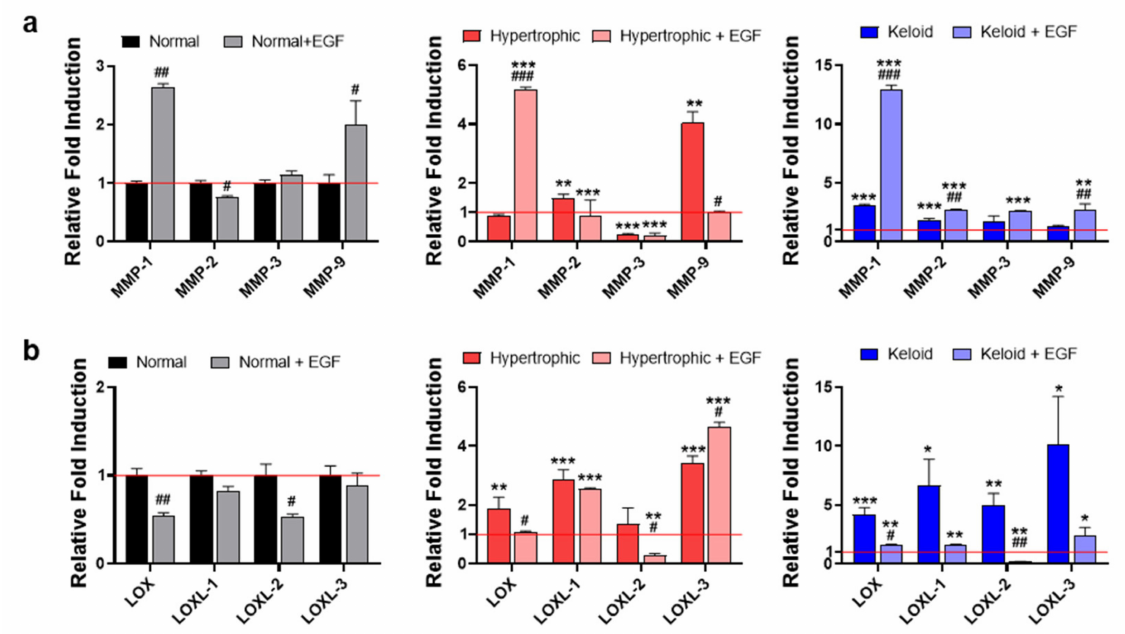
Figure 6. Exogenous EGF-mediated ECM remodeling in dermal fibroblasts from NHK patient-derived scar tissues. qPCR of ( a ) collagen-degrading MMPs and ( b ) collagen-cross-linking LOX and LOXLs in the presence or absence of EGF. Data were normalized against normal fibroblasts without EGF treatment. The red solid line represents gene expression in the control group (normal dermal fibroblasts). Data represent the mean ± SEM. * p < 0.05, ** p < 0.01, *** p < 0.001 vs. normal fibroblasts without EGF treatment; and # p < 0.05, ## p < 0.01, ### p < 0.001 vs. untreated